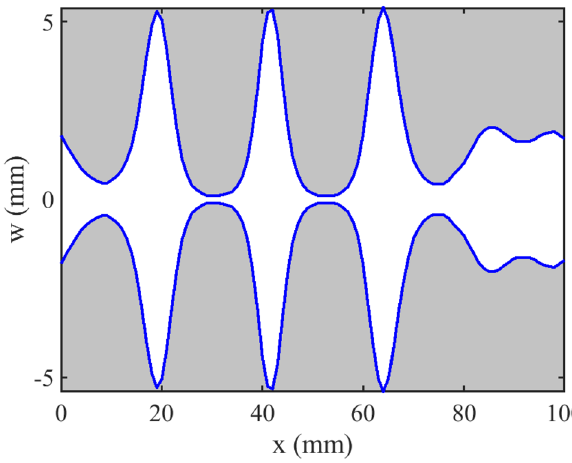
Figure 3. The profile of stop-band filter.